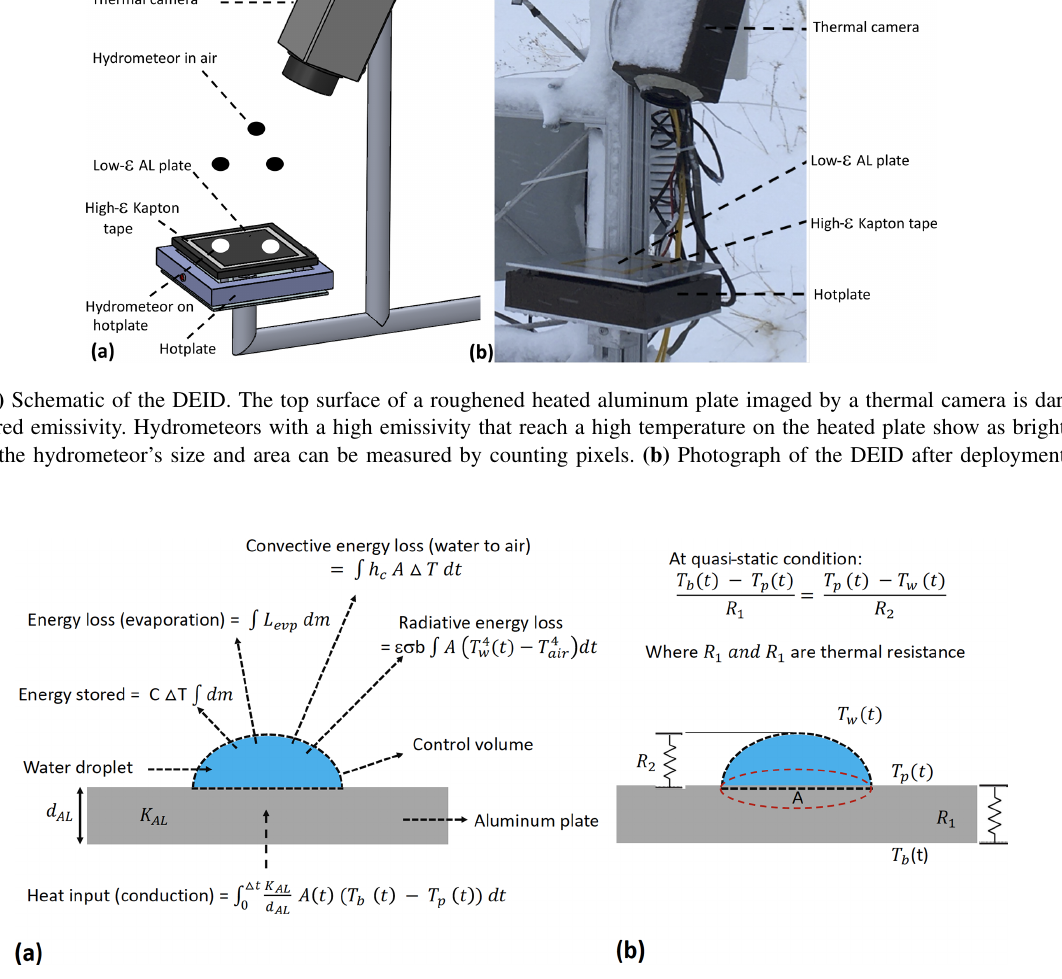
Figure 2. Schematic of a control-volume-based energy balance for a hydrometeor. (a) Distribution of heat gain and loss from a hydrometeor. (b) Schematic of heat flow between the series combination of the hotplate and the water droplet under quasi-static